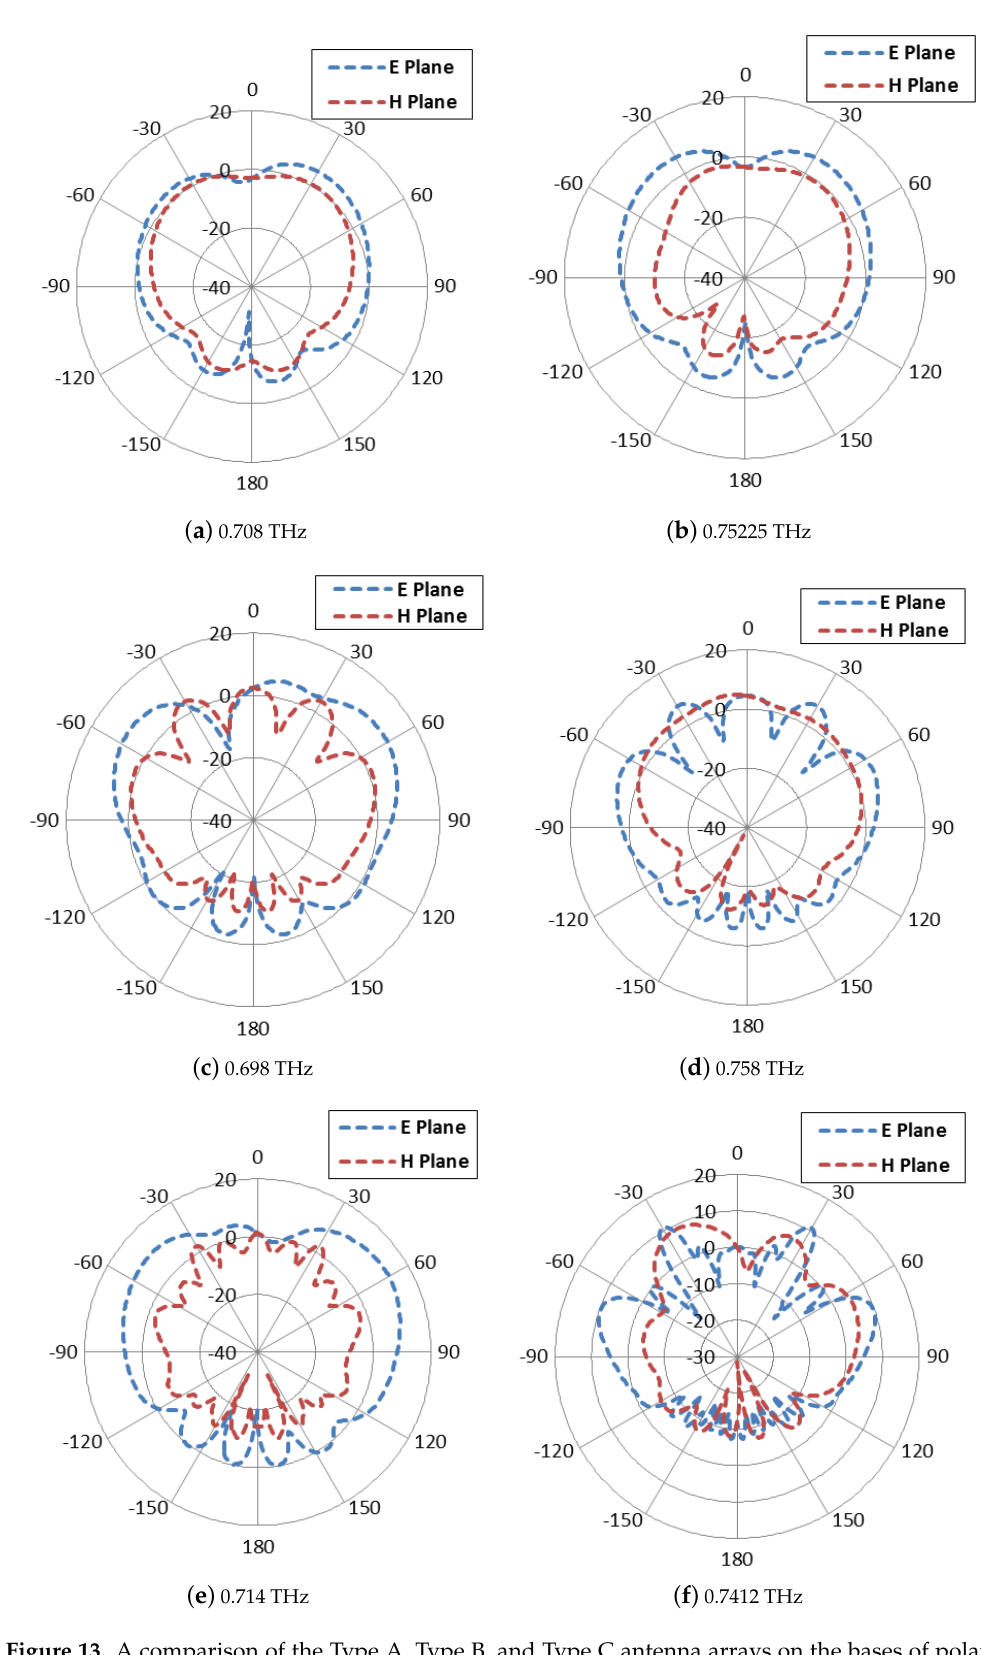
Figure 13. A comparison of the Type A, Type B, and Type C antenna arrays on the bases of polar plots: ( a ) Type A at 0.708 THz, ( b ) Type A at 0.75225 THz, ( c ) Type B at 0.698 THz, ( d ) Type B at 0.758 THz, ( e ) Type C at 0.714 THz, and ( f ) Type C at 0.7412